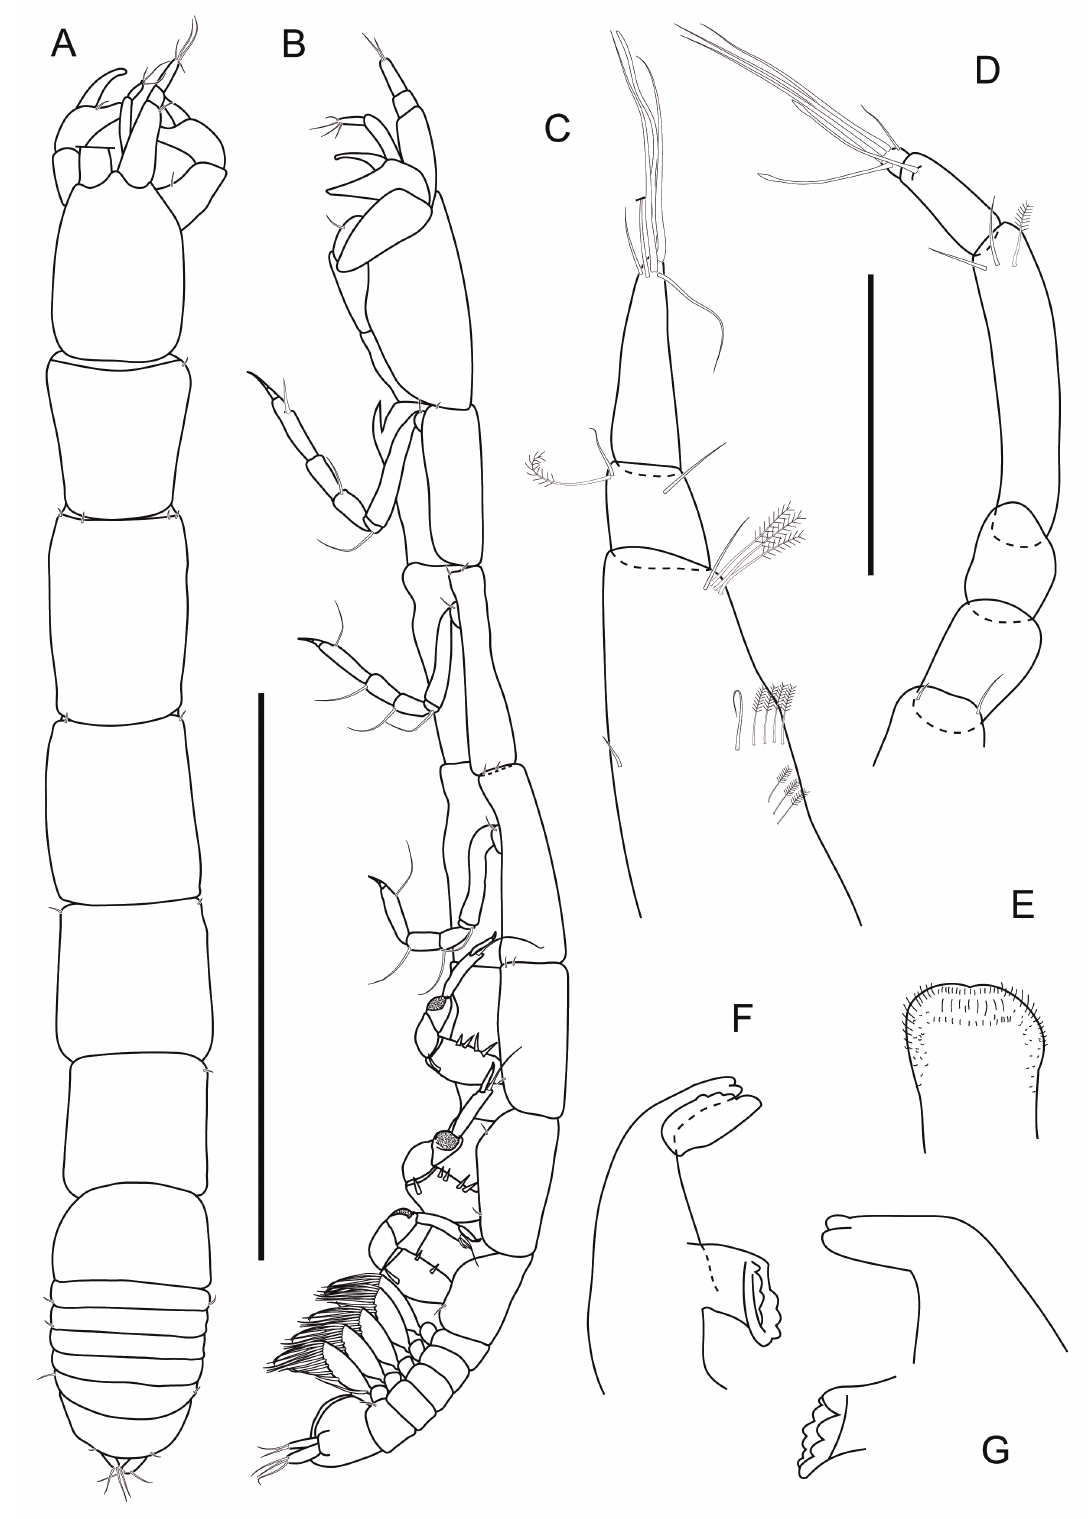
Fig. 17. Typhlotanais spinibasis sp. nov. A–B . Additional material, ♀ (MZUSP 34473). A . Dorsal view. B . Lateral view. C–G . Paratype (MZUSP 32893), ♀, dissected. C . Antennule. D . Antenna. E . Labrum. F . Left mandible. G . Right mandible. Scale bars: A–B = 1 mm; C–D = 0.1